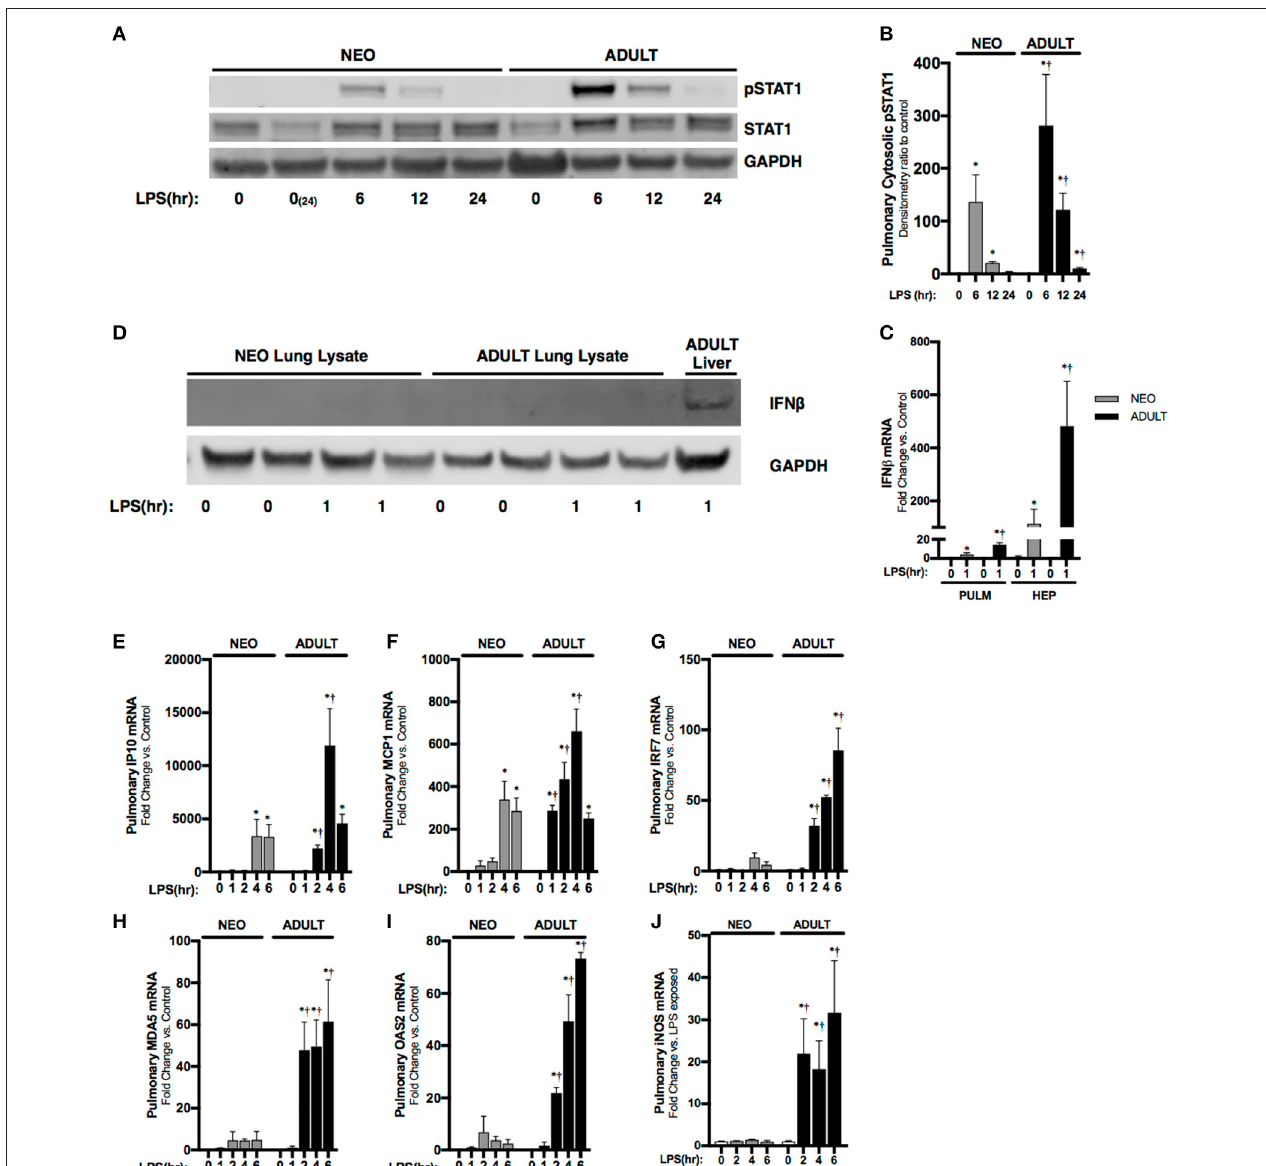
FIGURE 4 | Neonates demonstrate attenuated LPS-induced pulmonary STAT1 activation downstream of hepatic IRF3 activation and IFN β secretion. (A) Representative Western Blot of neonatal and adult pulmonary cytosolic extracts following LPS exposure (0–24h, 5 mg/kg) for phosphorylated and total STAT1 with GAPDH shown as loading control; two neonatal controls shown to reflect baseline conditions on PN0 and after 24h of life, at the completion of the exposure period. (B) Densitometry ratio to control of phosphorylated STAT1 in neonatal and adult pulmonary cytosolic extracts following LPS exposure. * p < 0.05 vs. control; † p < 0.05 vs. LPS-exposed neonate. Values shown as means ± SEM; n = 3–4/timepoint. (C) Fold-increase in gene expression of neonatal and adult pulmonary and hepatic IFN β following LPS exposure (0–1h, 5 mg/kg). * p < 0.05 vs. control; † p < 0.05 vs. LPS-exposed neonate. Values shown as means ± SEM; n